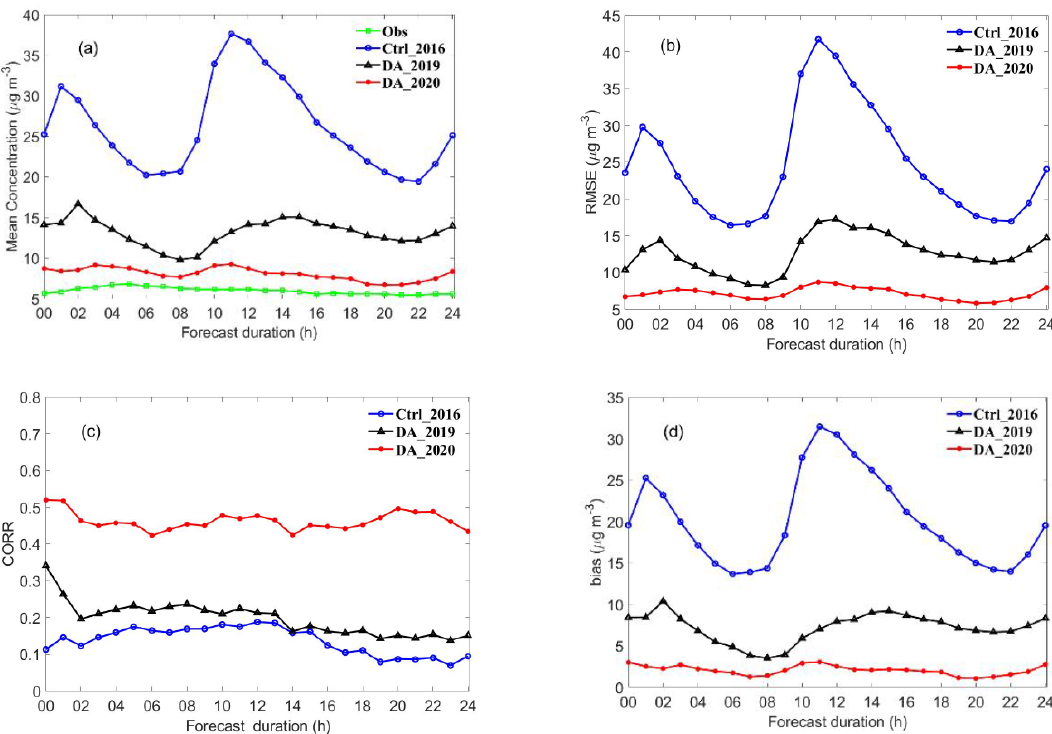
Figure 13. Forecast accuracy of SO 2 concentrations in central China using the Ctrl_2016, DA_2019, and DA_2020 experiments during the study period in 2020. (a) Mean concentration, (b) root mean square error (RMSE), (c) correlation coefficient (CORR), and (d) bias. Unit: µgm − 3 for (a) , (b) , and (d) . Obs: